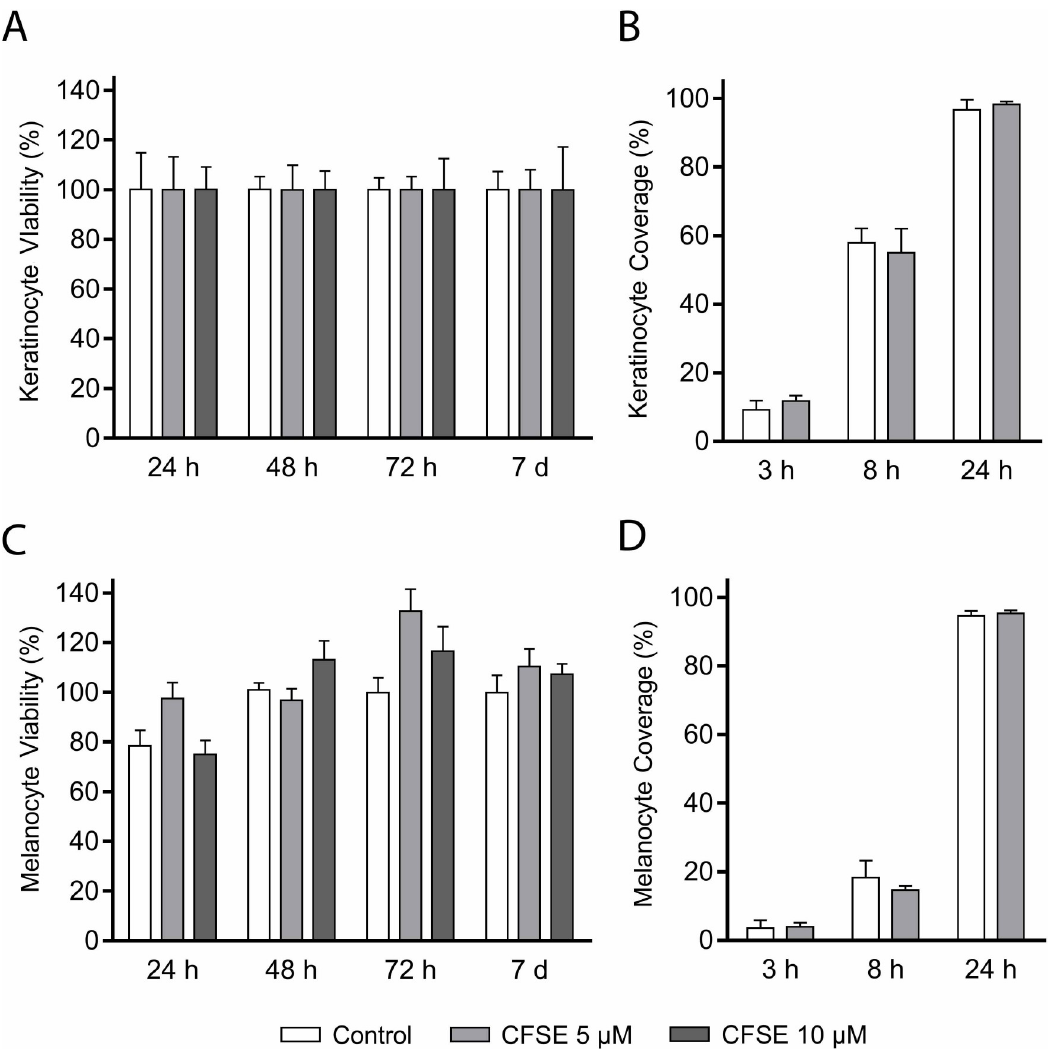
Fig 1. Viability and migration of CFSE-stained keratinocytes and melanocytes. The 5(6) carboxyfluorescein-N-hydroxysuccinimidyl ester (CFSE) diffuses over the cell membrane and is trapped inside the cell whenits acetate groups are cleaved by intracellular esterases. Cleavage yields a green fluorescence. Tested concentrations of CFSE did not significantly reduce viability (A) or migration (B) of keratinocytes, nor the viability (C) or migration (D) of melanocytes. Viability values are relative to the unstained control and reported in percentage (mean ± SD, p < 0.05,n = 6). Results from the migration scratch assay are reported as coverage of the initial cell free area in percentage (mean ± SD, p < 0.05,n = 6).